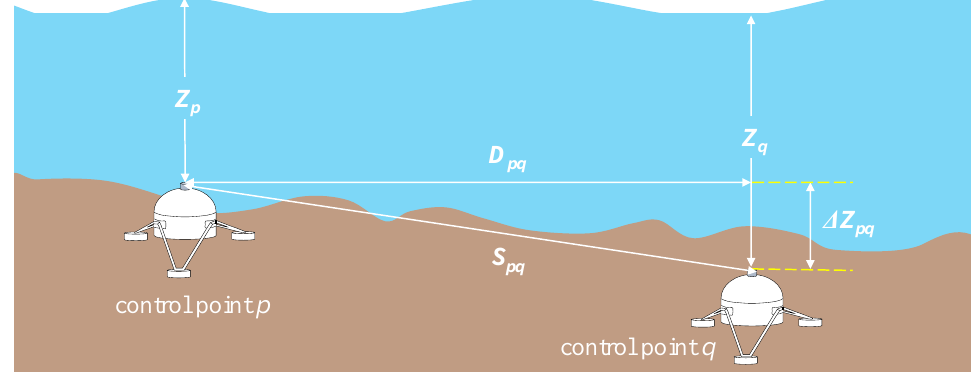
Figure 3. The geometric relations between control points in the unit network of the seafloor PNT network.